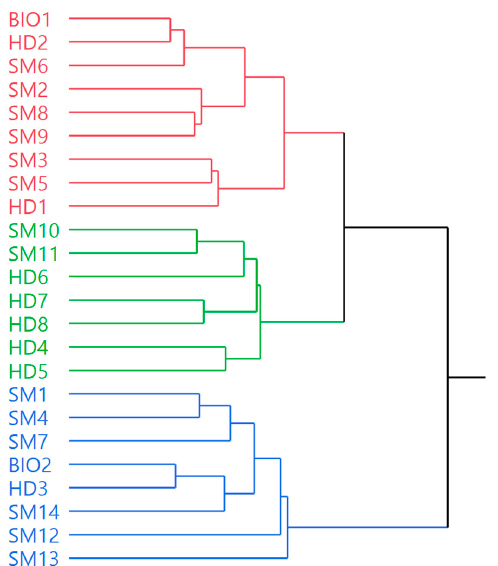
Figure 3. Dendrogram of the hierarchical cluster analysis (HCA) performed on the panel test data for all samples. Legend for the sample names: organic bars (BIO), supermarket bars (SM), and hard discount bars (HD).